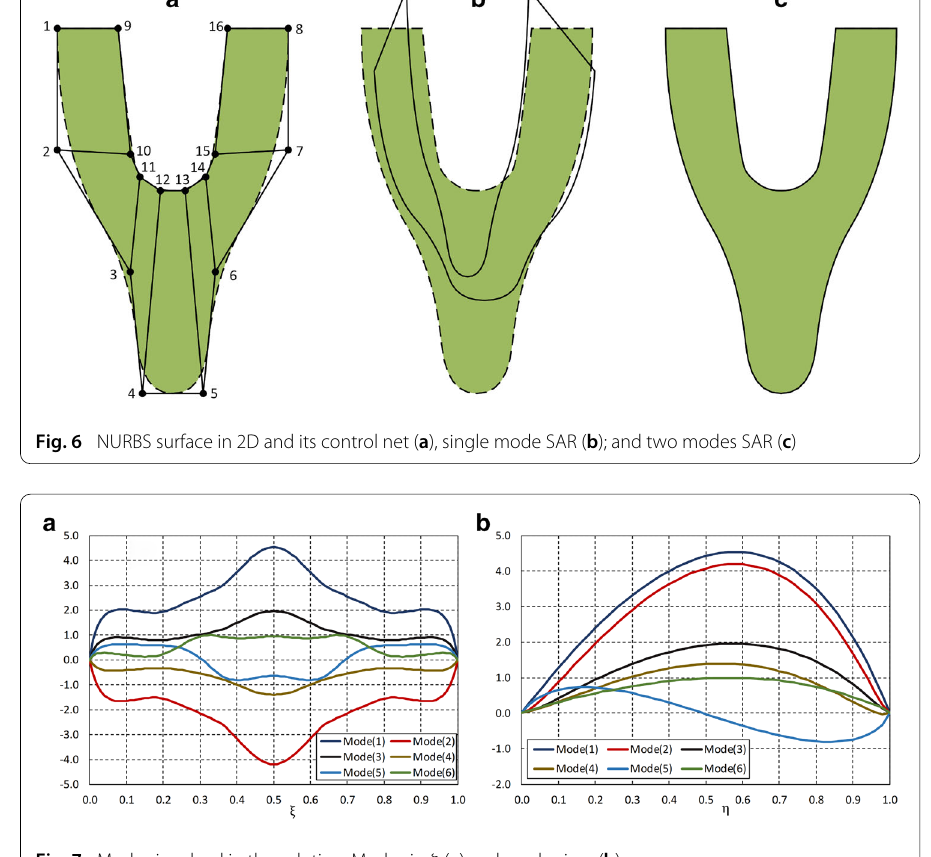
Fig. 7 Modes involved in the solution: Modes in ξ ( a ) and modes in η ( b